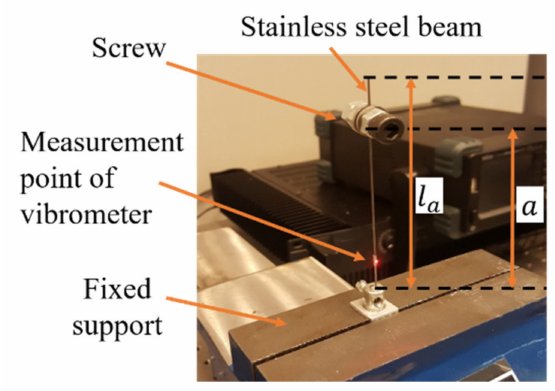
Figure 3. Manufactured cantilever-type